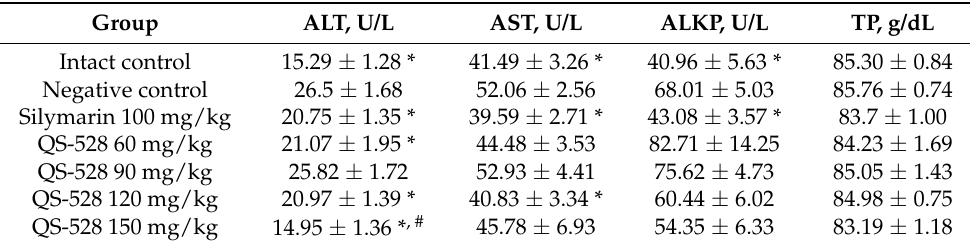
Table 1. Blood biochemical parameters of CD-1 mice treated for 3 weeks with QS-528 at a dose of 60, 90, 120 or 150 mg/kg.